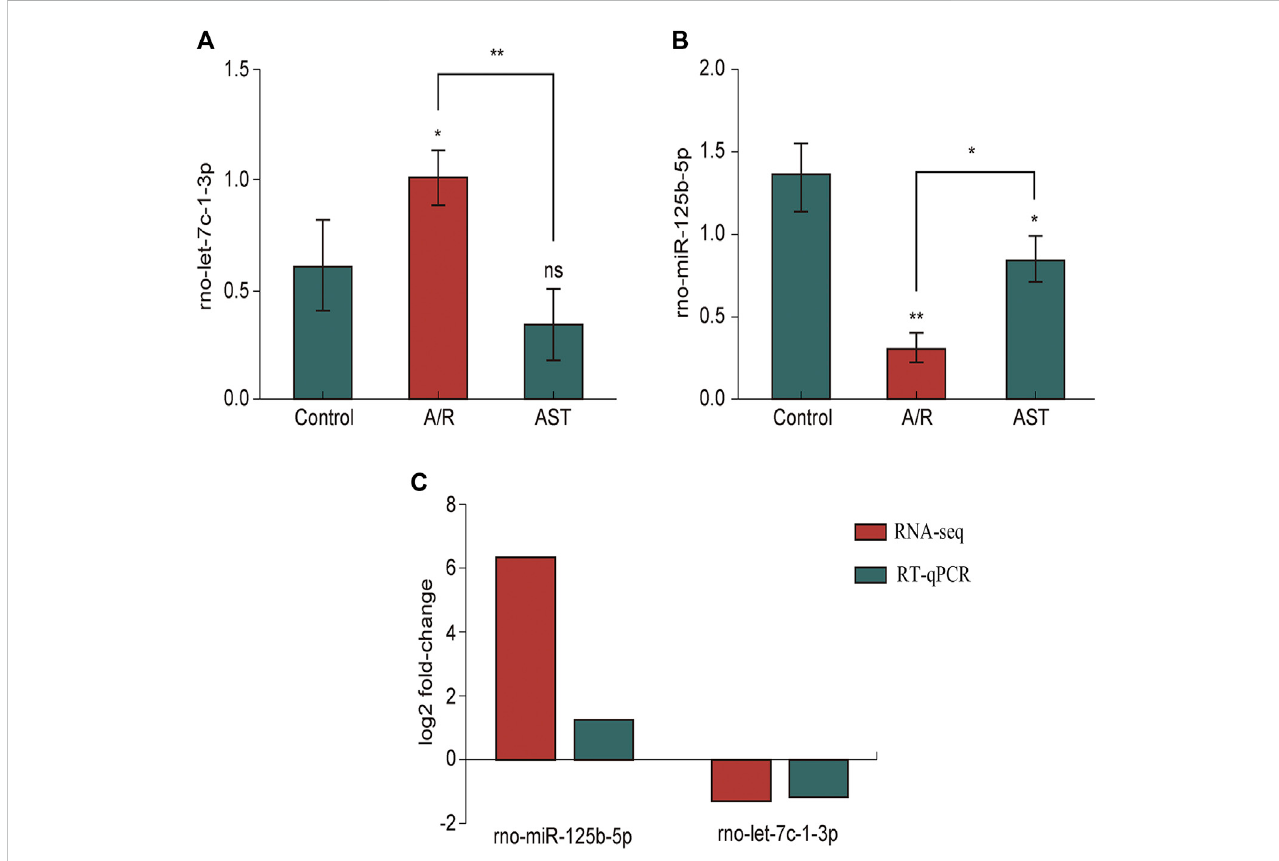
FIGURE 6 RT-qPCR analysis of the expression of rno-miR125b-5p (A) , Let-7c-1-3p (B) . (C) Comparison of RNA-seq and RT-qPCR results for selected differentially expressed microRNAs (* p < 0.05; ** p < 0.01). A/R, anoxia reoxygenation; AST, astaxanthin.